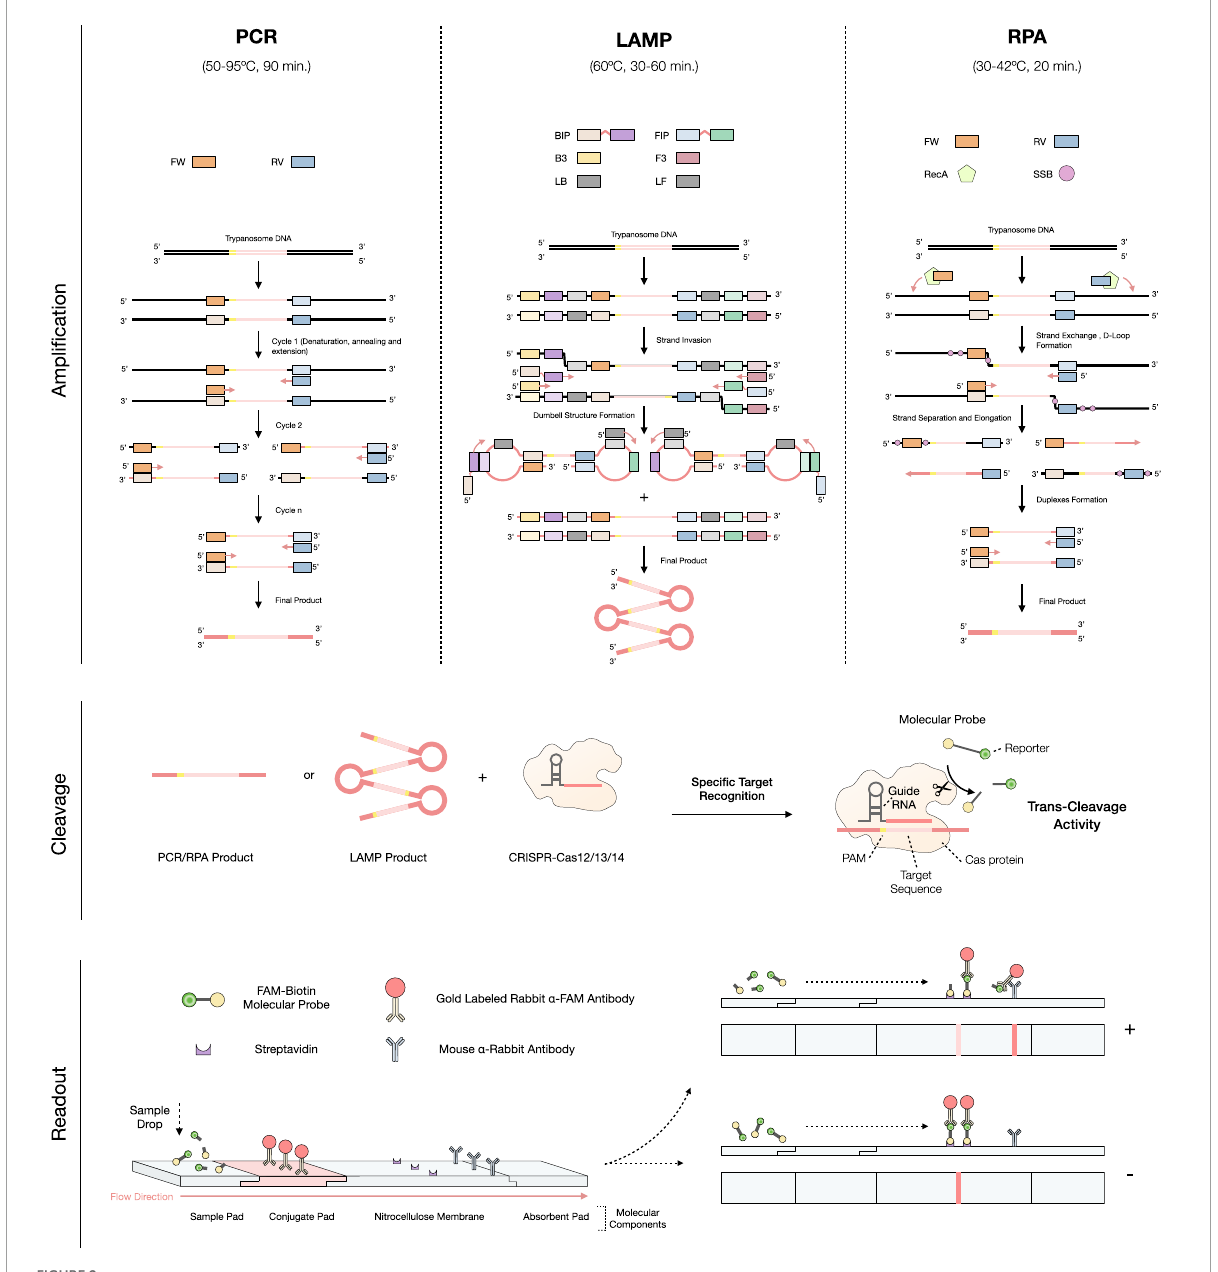
FIGURE2 Overview of the implementation of the CRISPR-Cas technology to the molecular-based diagnosis for Human African Trypanosomiasis (HAT) infections. The first step consists in the amplification of the target DNA/RNA through PCR, LAMP, or RPA. In PCR: FW (Forward Primer) and RV (Reverse primer); In LAMP: BIP (Backward Inner Primer), FIP (Forward Inner Primer), B3 (Backward 3 Primer), F3 (Forward 3 Primer), LB (Loop Backward Primer) and LF (Loop Forward Primer); in RPA: FW (Forward Primer), RV (Reverse Primer), RecA (Recombinase A), and SSB (Single Stranded Binding Protein). Squares matching the same colors as the primers but with a lighter shade correspond to the complementary sequence of these. Then, the cleavage process occurs, by applying the CRISPR-Cas technology to the amplification products. Finally, the readout procedure, which is based on the detection of the molecular probes, can be performed by lateral flow immunoassay.